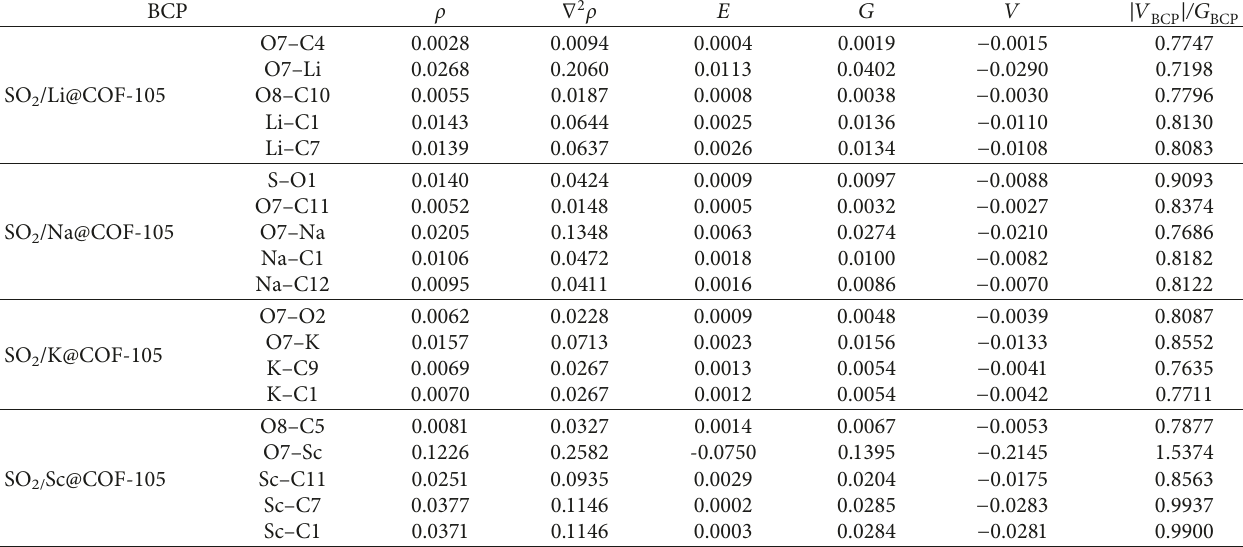
2 /metal@COF-105.